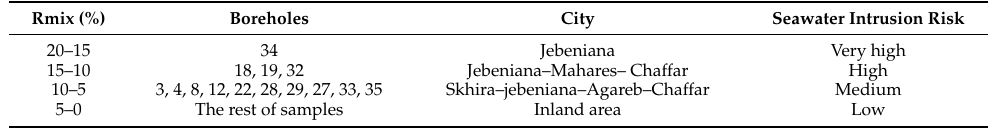
Figure 13. Rmix evaluation and spatial distribution. Table 4. Spatial ranking of seawater hazard.